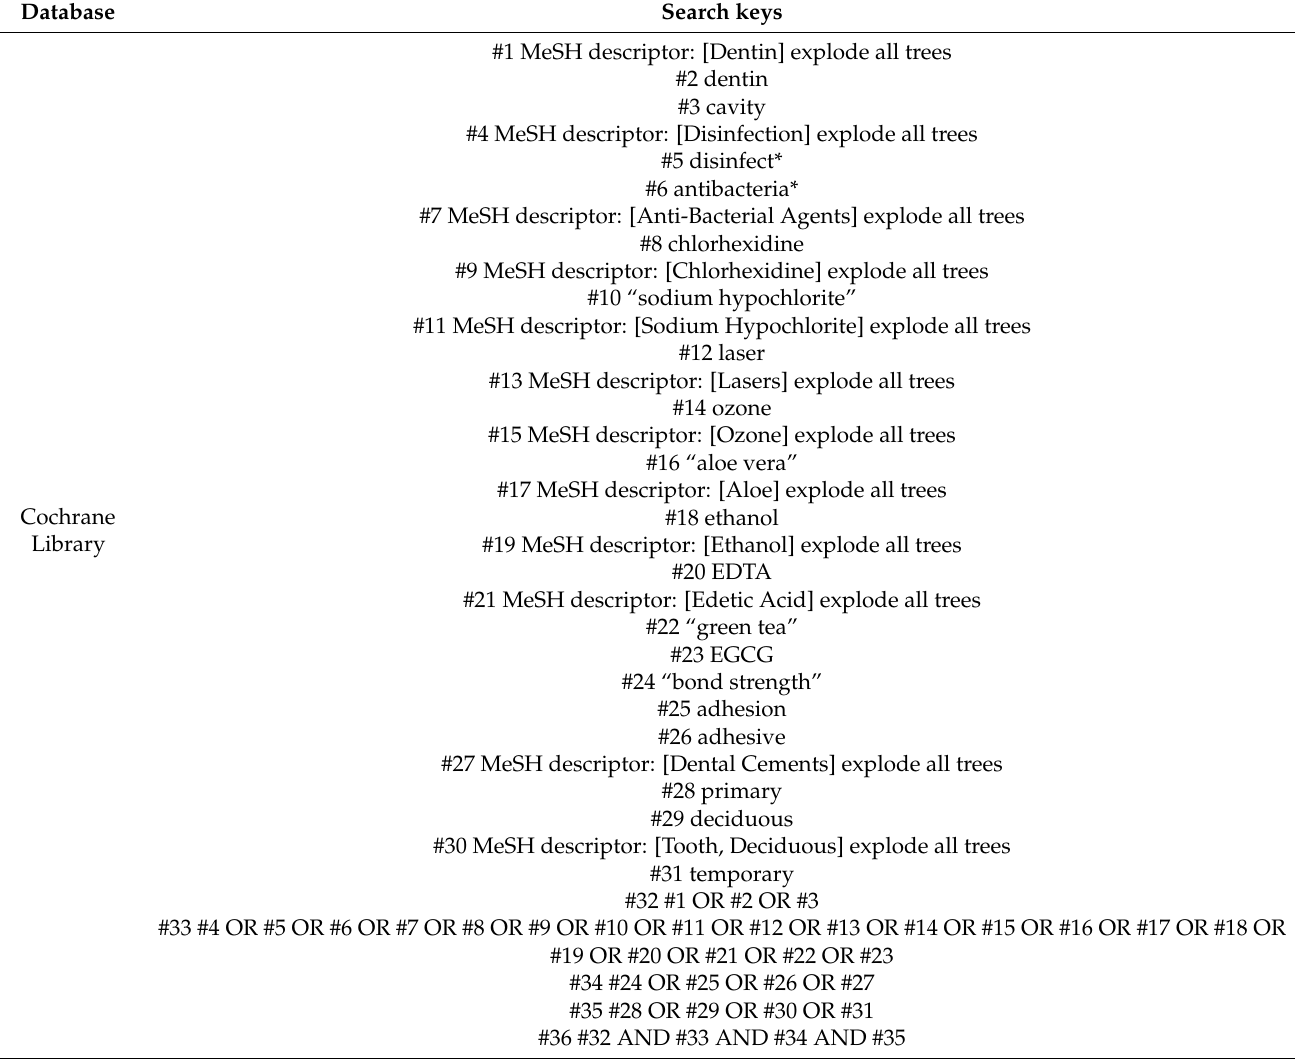
Table 5. Search keys used in the different